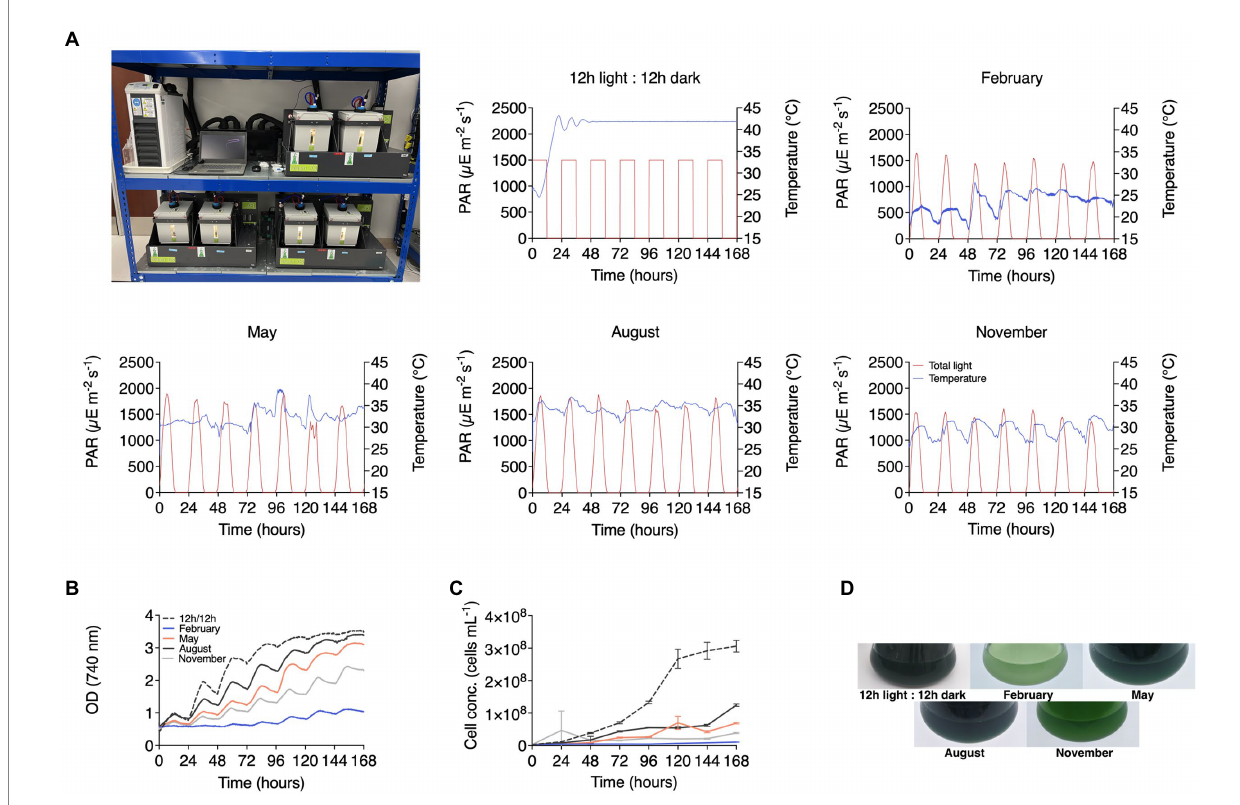
FIGURE 1 Modeled seasonal productivity variation of C. merolae 10D in photobioreactors. (A) Temperature and light profiles in Algem photobioreactors (pictured) which are based on historical weather data from Thuwal, Saudi Arabia were used to cultivate C. merolae 10D in MA2 medium and assess performance across different months in this locale. A control culture was set to 42 ° C with 12:12 h day:night illumination cycling, while February, May, August, and November profiles were used to model winter, spring, summer, and autumn, respectively. Growth performance was assessed by optical density (B) recorded every 10 min in the bioreactors and cell densities (C) which were recorded daily by flow cytometry. (D) Culture health and densities were also assessed photographically at the end of cultivations.